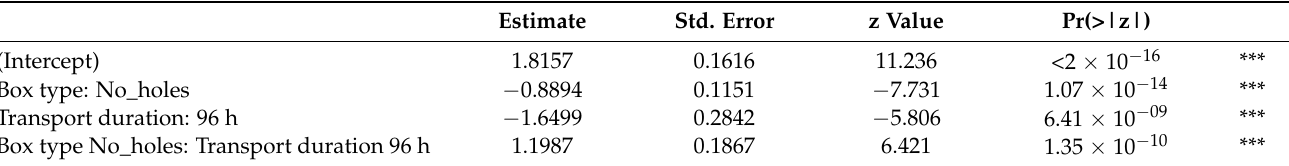
Table 1. Fixed effects of mosquito compaction box type and recovery time on the escape rate of Aedes aegypti , Senegal strain, during long-distance